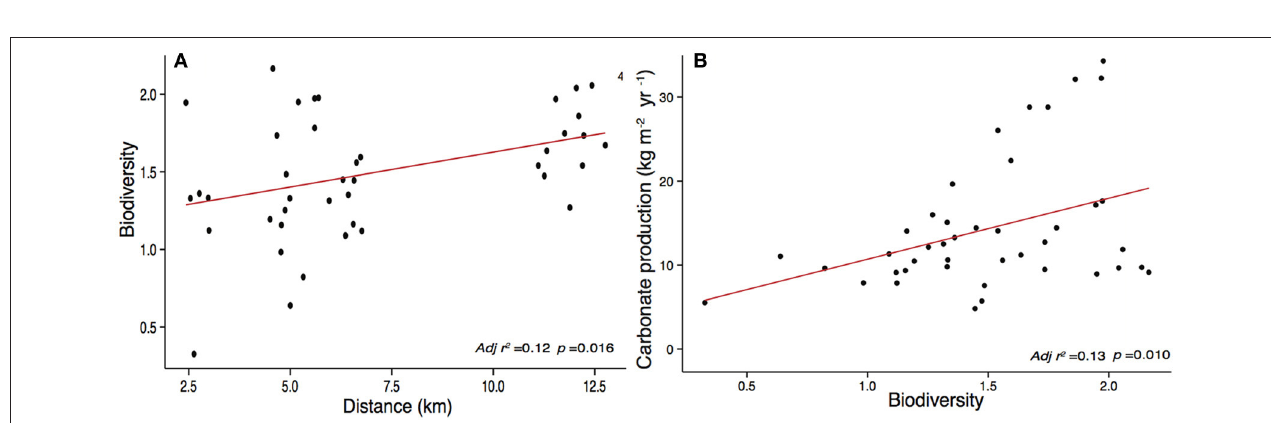
FIGURE 7 | Linear regression model showing the significant relationship ( p < 0.05) between (A) biodiversity and distance to Stone Town and (B) calcium carbonate production and Shannon -Wiener biodiversity index.